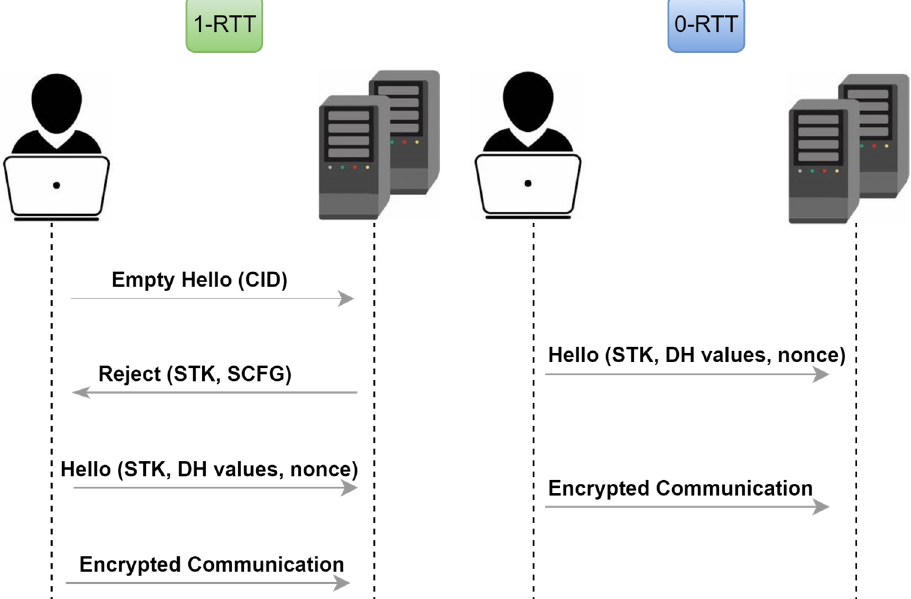
Figure 1. QUIC connection: In 1-RTT, the user sends an empty hello message and waits for the server’s rejection message. Then, the user sends the actual hello message to establish the connection. In 0-RTT, the client establishes the connection by sending the actual hello directly, without the empty hello message.